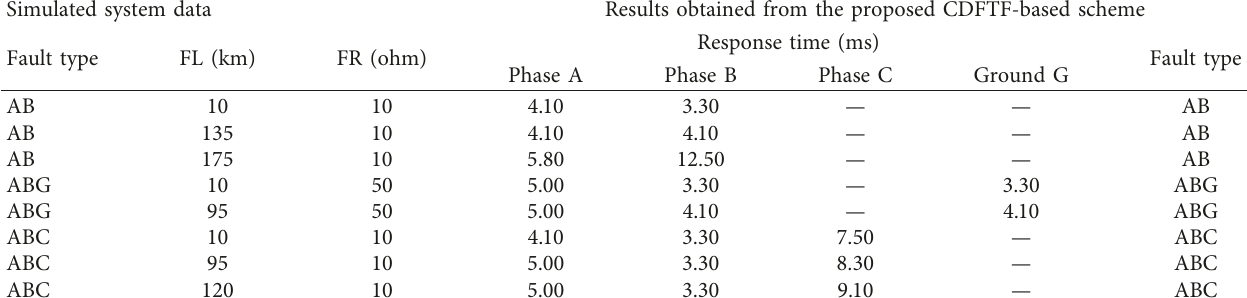
Table 4: Effect of fault location (FIA � 0 ° ).